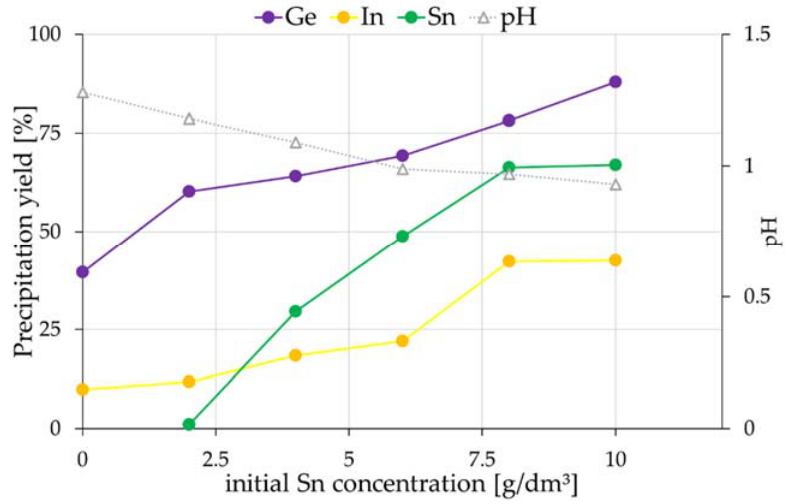
Figure 3. Influence of Sn concentration in the solution on precipitation yields of Ge, In, and Sn, and final pH (60 °C, 2 h, 50 g/dm 3 Zn used).